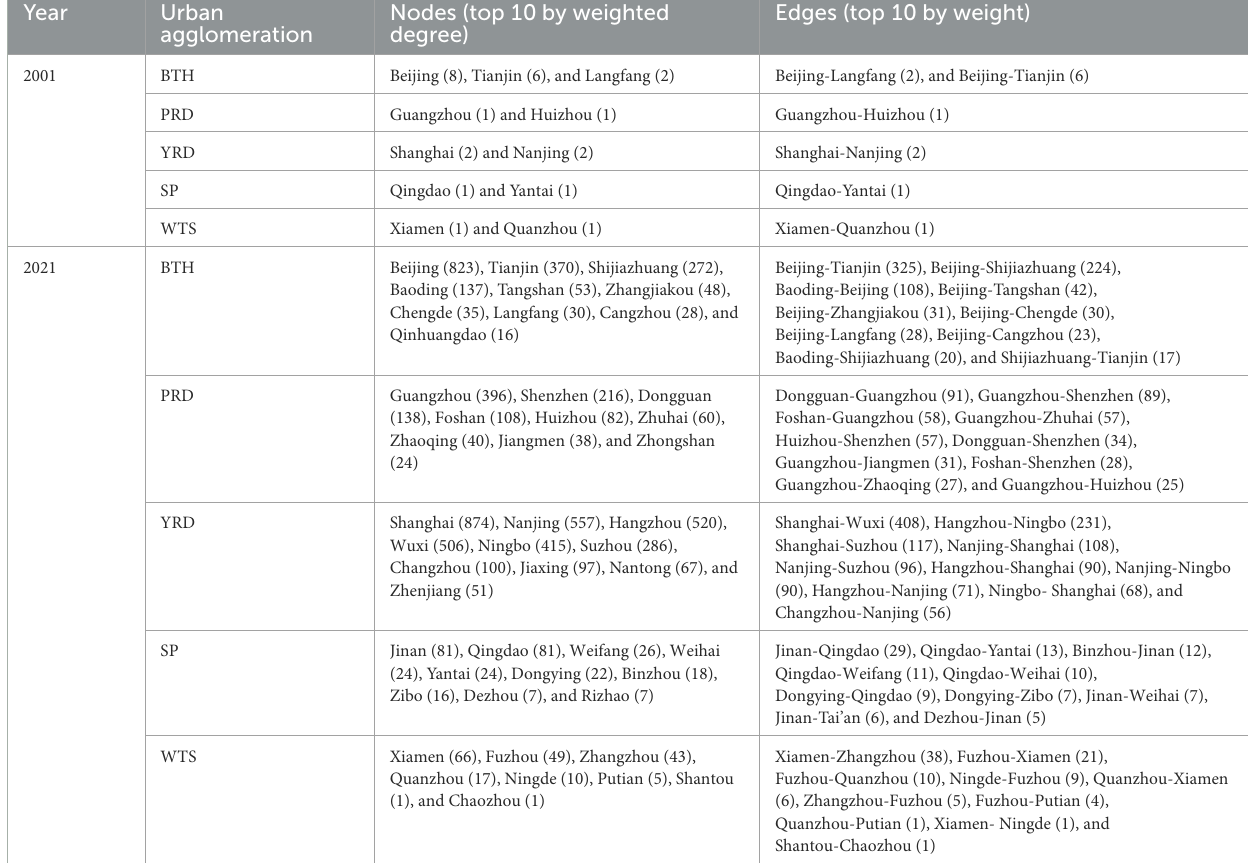
TABLE 12 Spatial pattern of interurban low-carbon patent cooperation networks in 2001, 2011, and 2021.